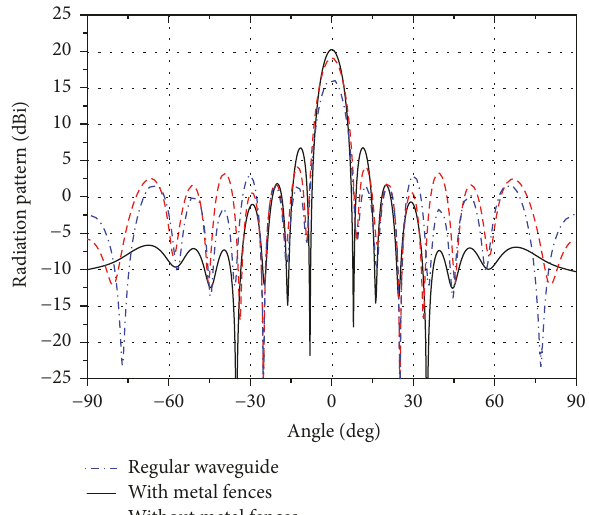
Figure 7: Radiation pattern of slot antenna based on the regular waveguide, the T-shaped waveguide with/without fences in 𝐸 -plane at 35